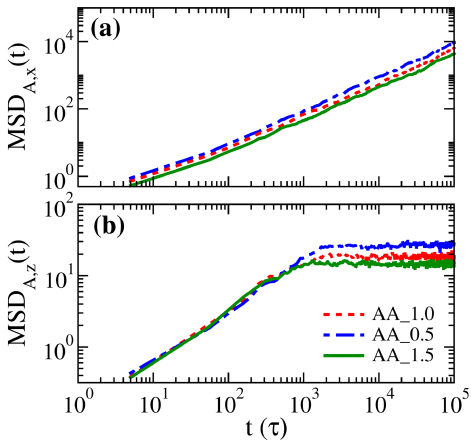
Figure 10. Mean square displacements of free particles in ( a ) the parallel direction and ( b ) the perpendicular direction for AA_0.5, AA_1.0, and AA_1.5 systems.